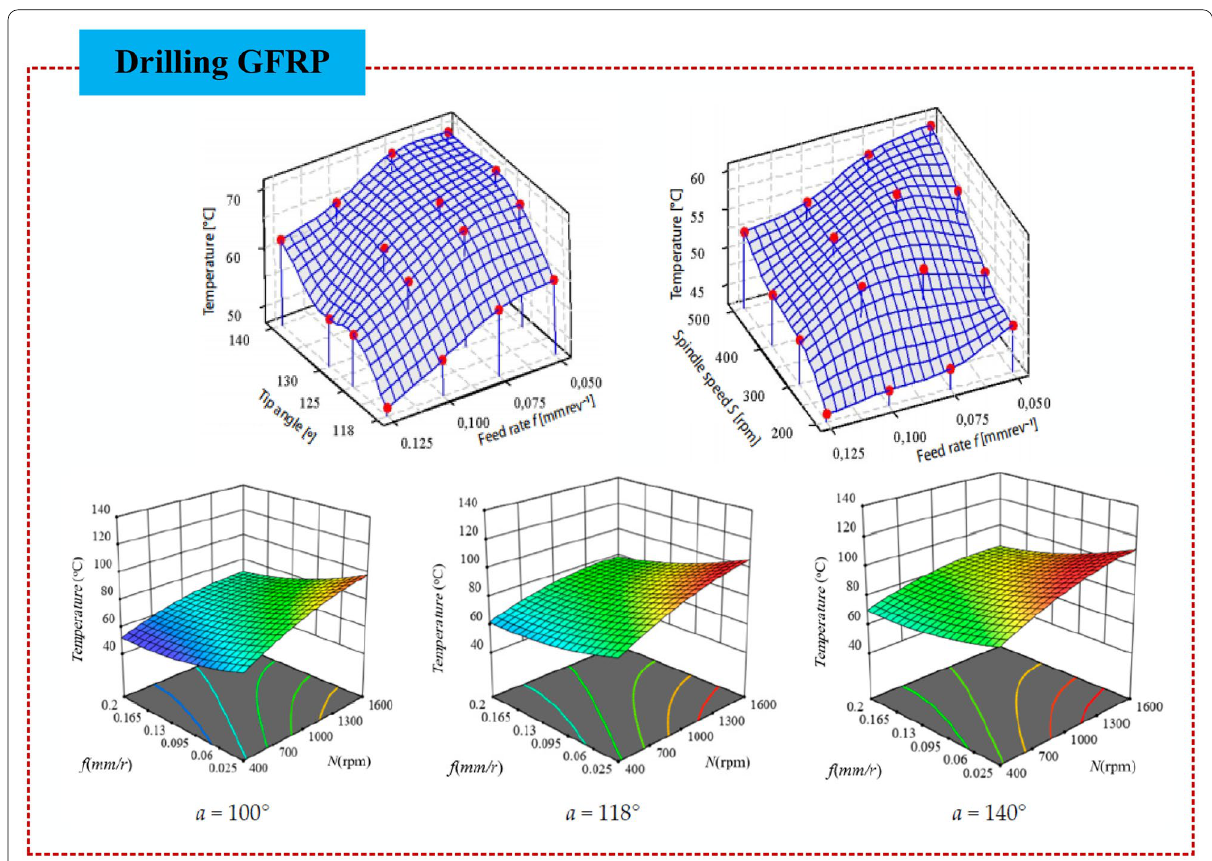
Figure 15 Drilling temperature when drilling GFRP [57,